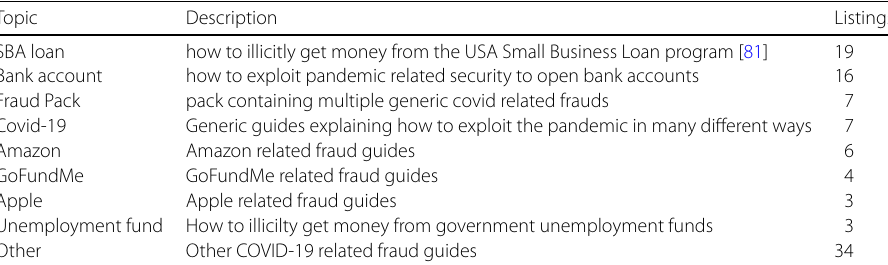
Table 9 COVID-19 related guides on scamming appearing in the listings, together with a brief description and the number of listings related to that sub-category